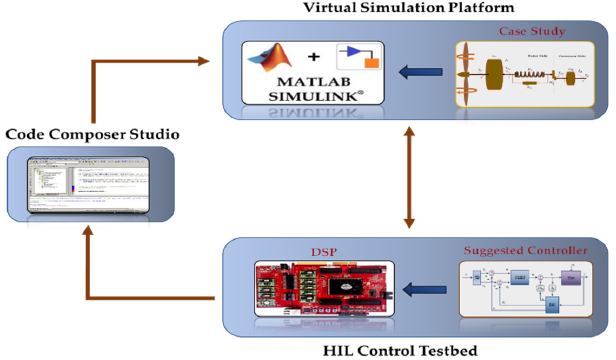
Figure 6. The concept of hardware-in-loop (HIL) testing.